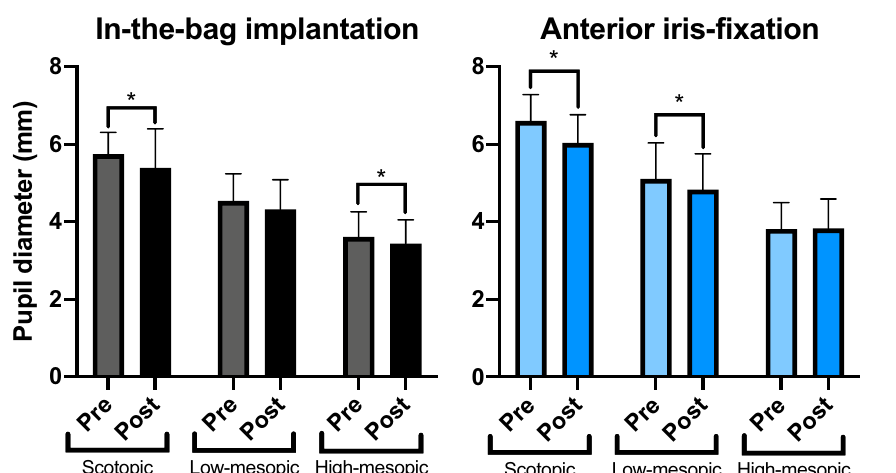
Figure 1. Preoperative versus postoperative pupil size for anterior iris fixation and in-the-bag implantation at different levels of illumination Preoperative data was available for a subset of patients undergoing IB and IFPH. After surgery, both groups showed significantly decreased maximum pupil size under scotopic lighting compared to preoperative